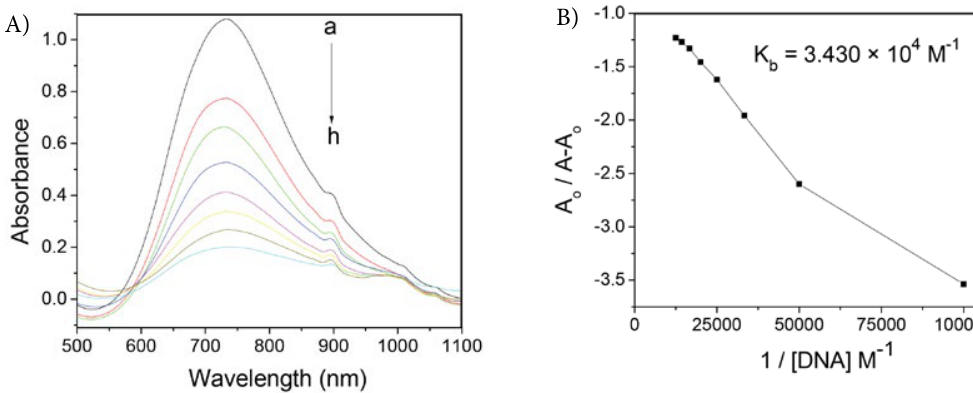
Fig. 5. A , reduction in absorbance of pure complex with addition of DNA. B , plot for calculation of binding constant K